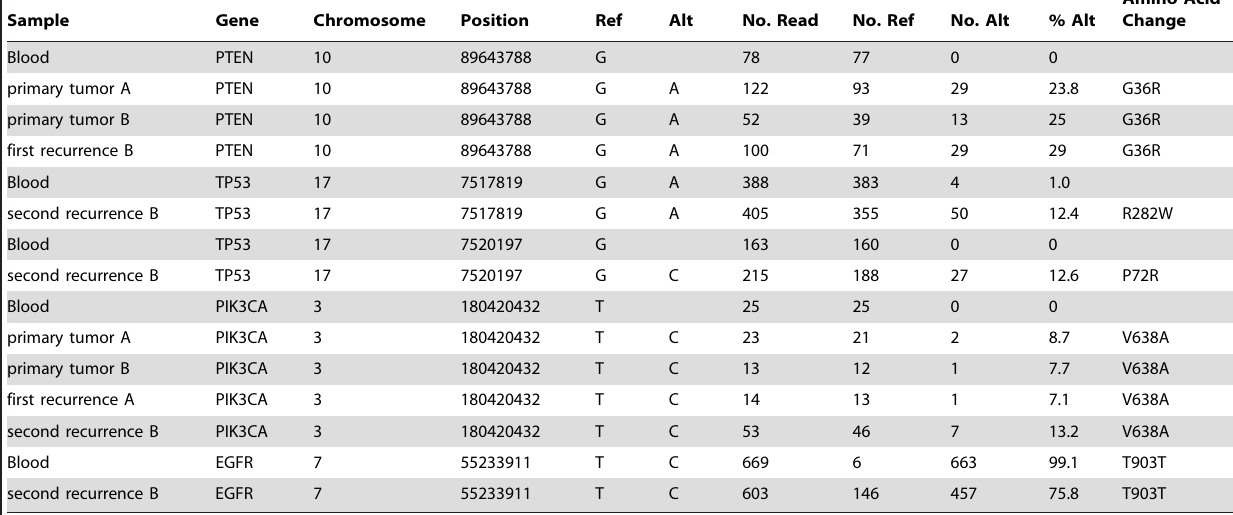
Table 1. Somatic mutations.